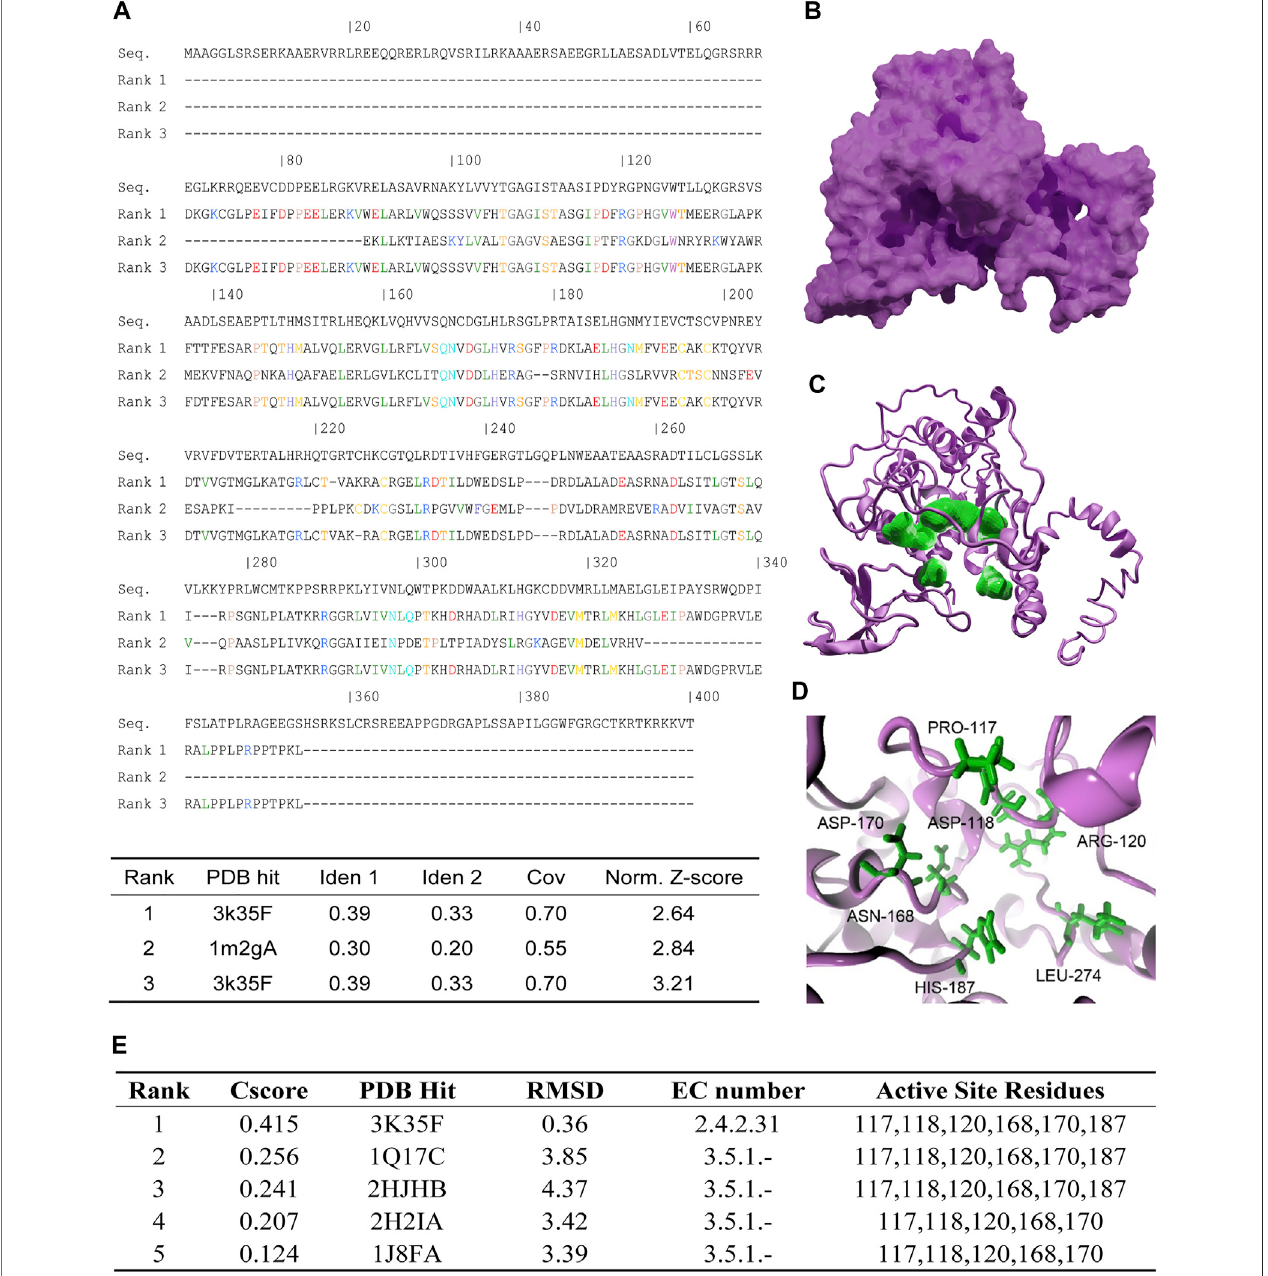
FIGURE 1 | Protein structure prediction and analysis of human SIRT7. (A) Top 3 threading templates used by I-tasser. PDB hit indicates the PDB ID of the best aligned. Ident1 indicates percentage of sequence identity of the templates in the threading aligned region with the query sequence. Ident2 indicates the percentage sequence identity of the whole template chains with query sequence. Cov represents the coverage of the threading alignment and is equal to the number of aligned residues divided by the length of query protein. Norm. Z-score indicates the normalized Z-score of the threading alignments. (B) The threading result of human SIRT7: magenta surface represents SIRT7. (C) The active sites predict result of SIRT7, magenta cartoon represents SIRT7, and green surface represents the key residues. (D) Enlarged active sites of SIRT7: green sticks represent the key residues. (E) The predicted results of active site residues. Cscore indicates the con fi dence scoreoftheprediction.Cscorerangesfrom0to1,whereahigherscoreindicatesamorereliableprediction.PDBhitindicatesthePDBIDofthealigned.RMSDindicates the RMSD between residues that were structurally aligned by TM-align. EC number represents the Enzyme Commission number which was a numerical classi fi cation scheme for enzymes. EC number 2.4.2.31 represented the protein was a NAD (+) protein-arginine ADP-ribosyltransferase. EC number 3.5.1 represented the protein was acting on carbon – nitrogen bonds other than peptide bonds in liner